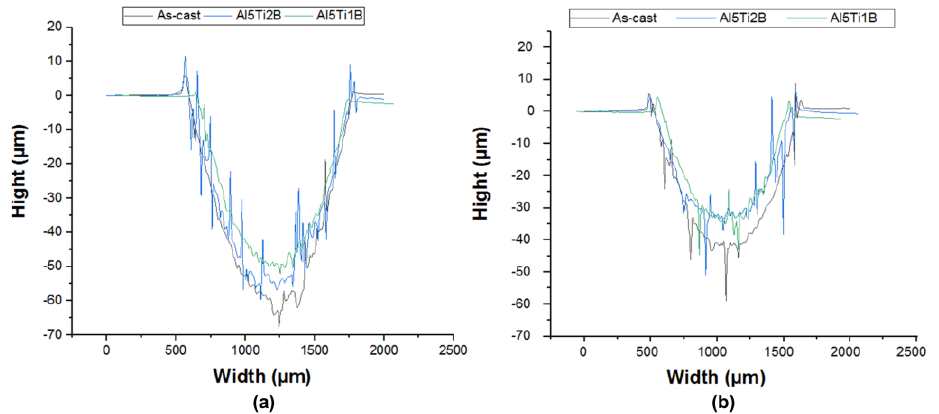
Figure 11. Comparison of 2D surface profile of A332 samples after wear test in ( a ) deep regions; ( b ) shallow of the wear tracks.